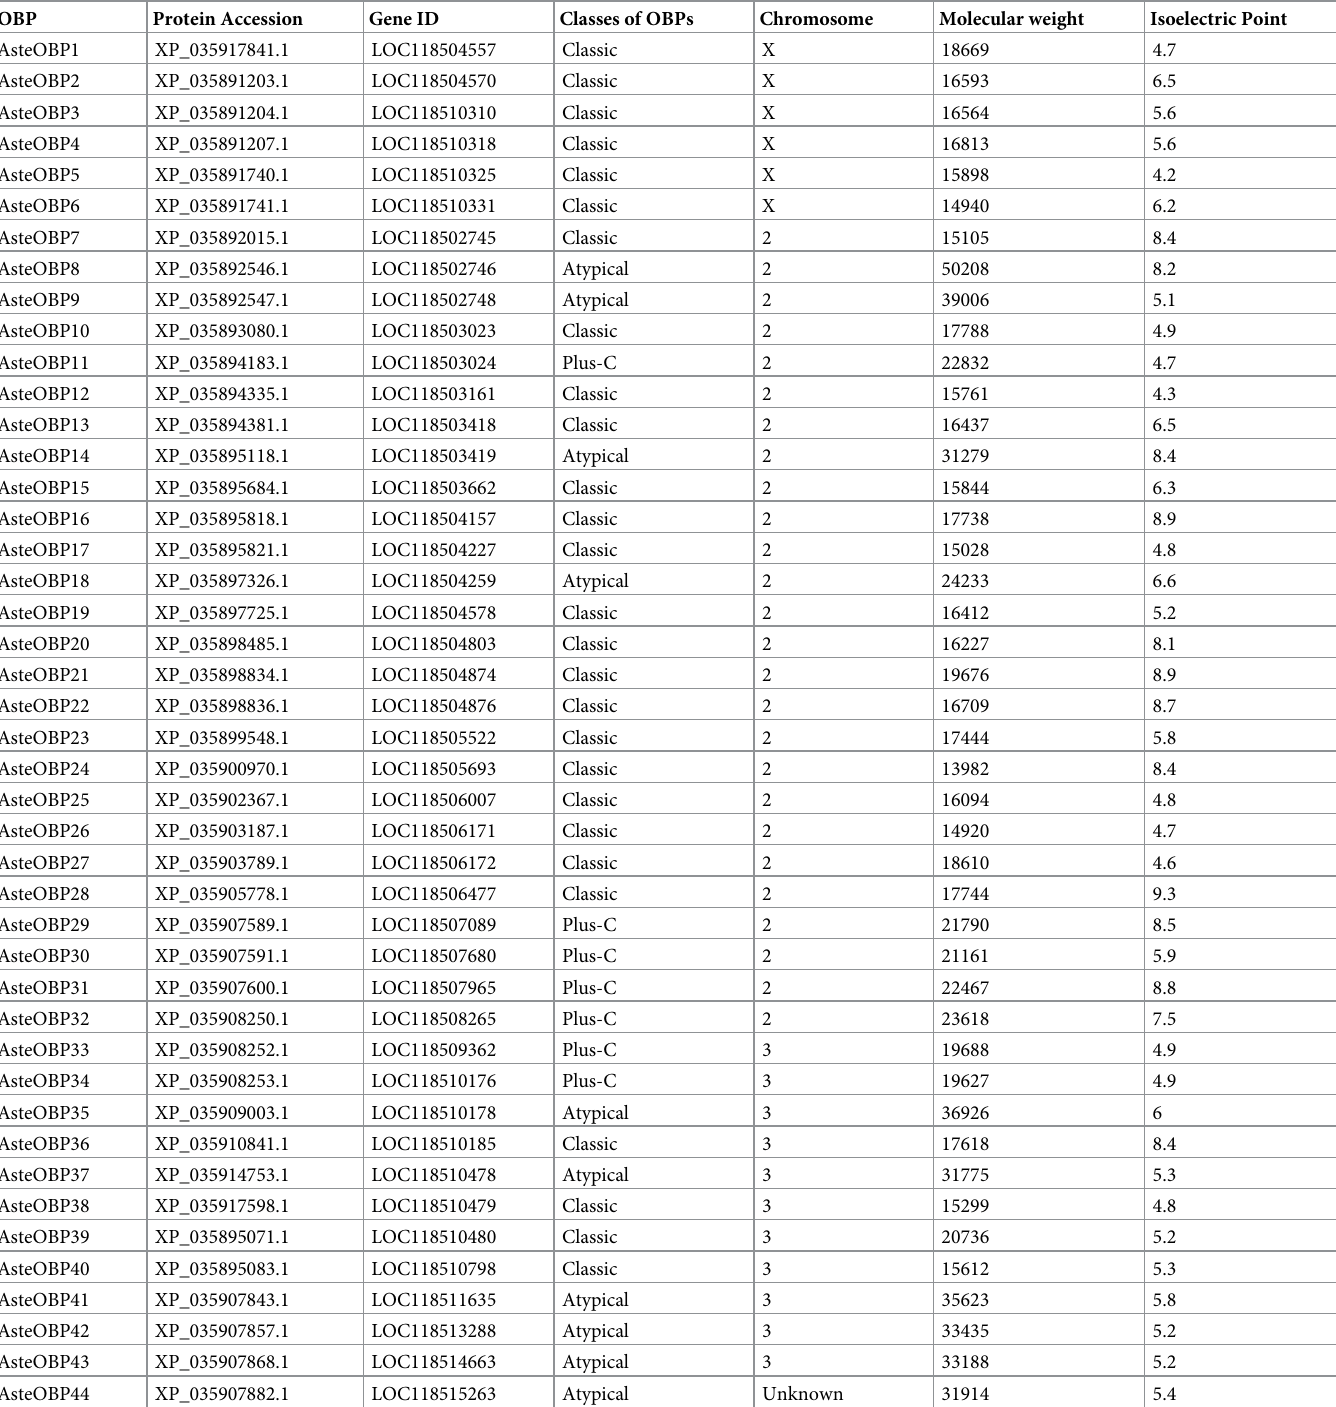
Table 1. Classification and NCBI accessions of identified OBPs.